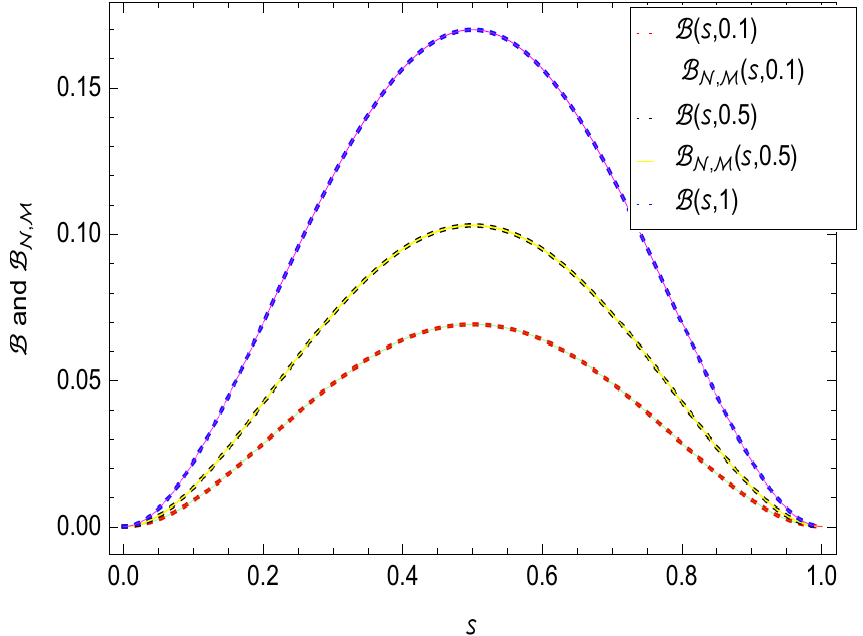
Figure 3. ς -direction graphs of numerical and exact solutions of problem (17), where ε = 1.4, ν = 0.1, N = M =